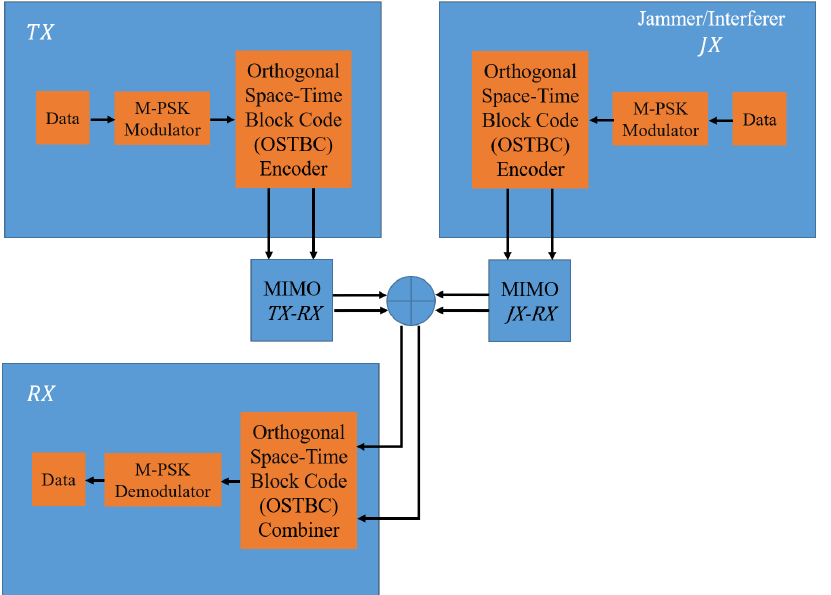
Figure 4. Simulation general block diagram of the signal and interferer using a 2 × 2 Alamouti tech- nique.